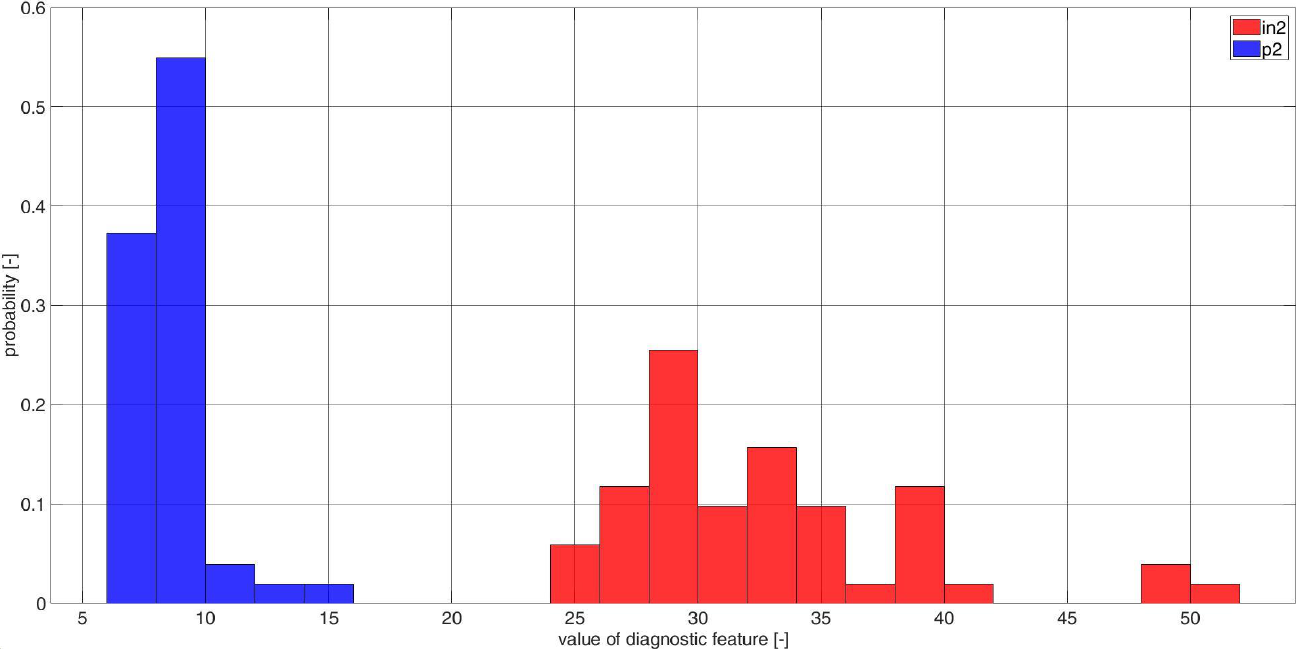
Figure A25. Histograms of diagnostic features based on the CCSM3 (correlation number is 28— Table A1) bearings in1 and p1. Table A1) bearings in1 and p1.